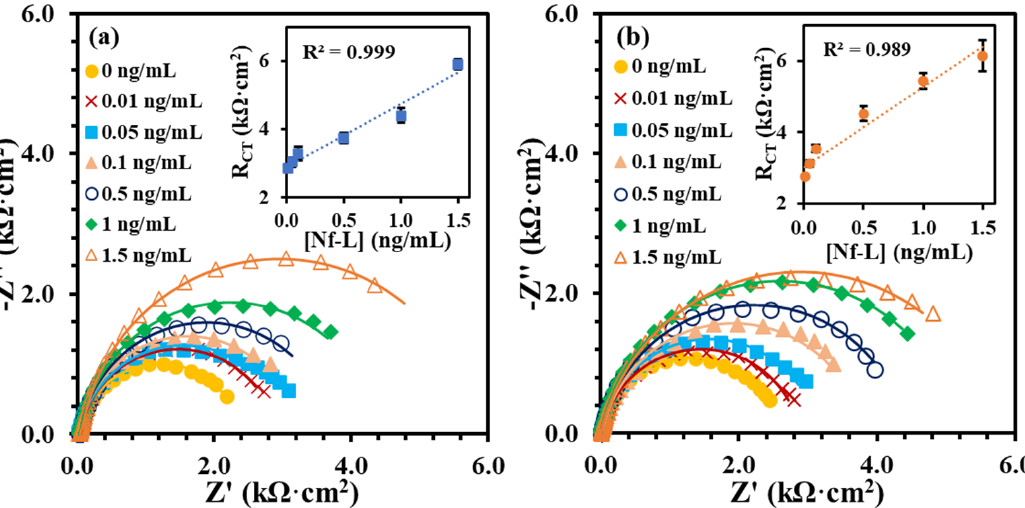
Figure 2. EIS signals of the synthetic Nf-L target captured at the immunoplatform from concentration range (0.01 to 1.5 ng/mL) in buffer medium PBS pH 7.4 ( a ) and in serum ( b ). The insets in ( a , b ) show corresponding calibration plots of R CT vs. concentration. Each error bar represents n ≥ 3 replicates.